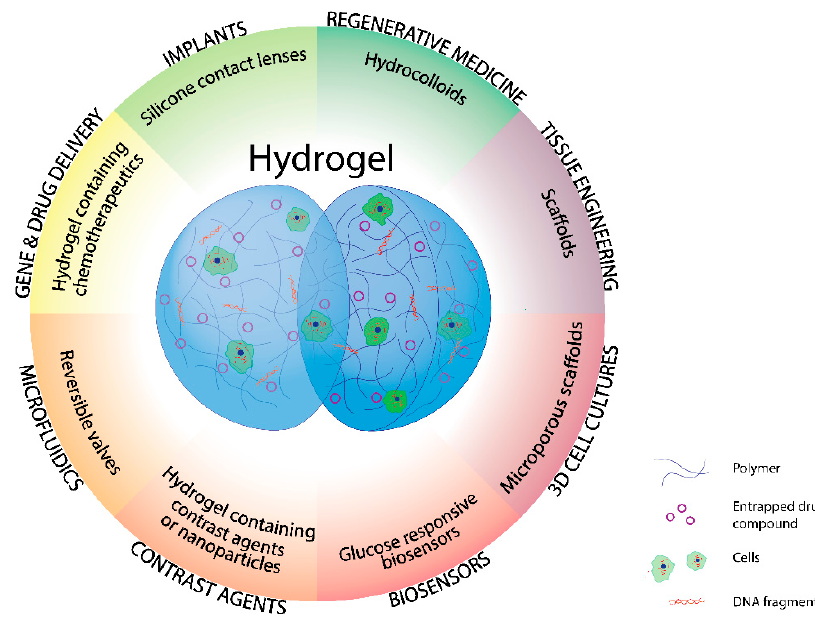
Figure 1. Hydrogel medical applications.